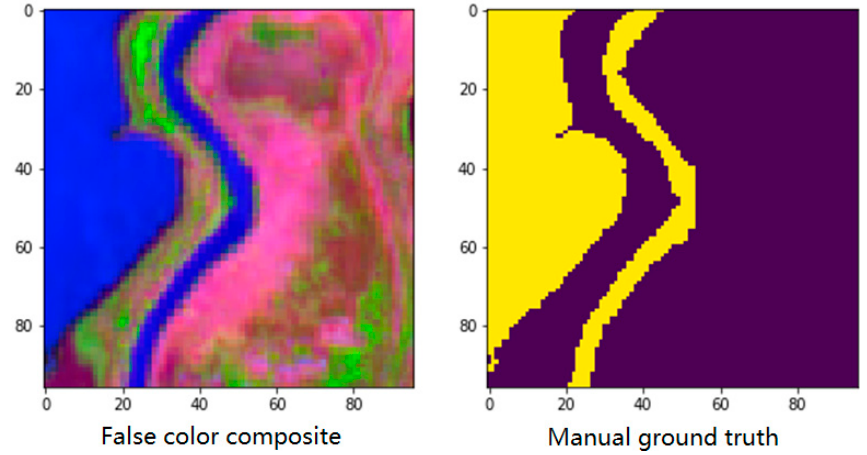
Figure 4. Example of the sample visualization and manual ground truth in the dataset.